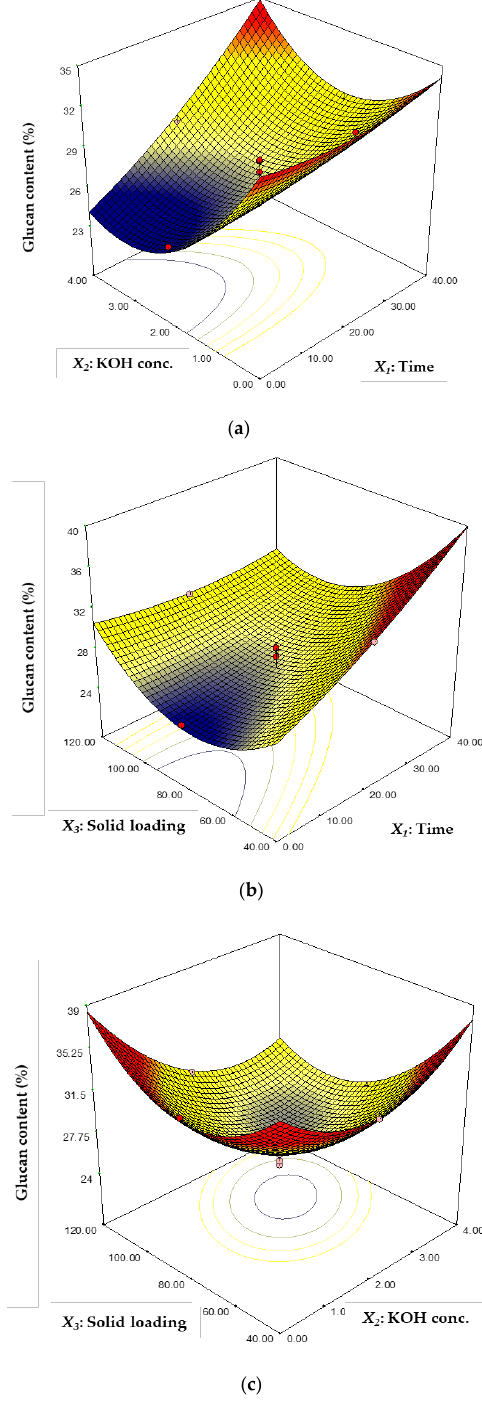
Figure 1. Three-dimensional (3D) response surfaces indicating the effects of thermal–alkaline pre- treatment variables. The effects of X 1 and X 2 on glucan content (GC) ( a ); the effects of X 1 and X 3 on GC ( b ); the effects of X 2 and X 3 on GC ( c ). (X 1 : time, X 2 : KOH concentration and X 3 : solid loading).